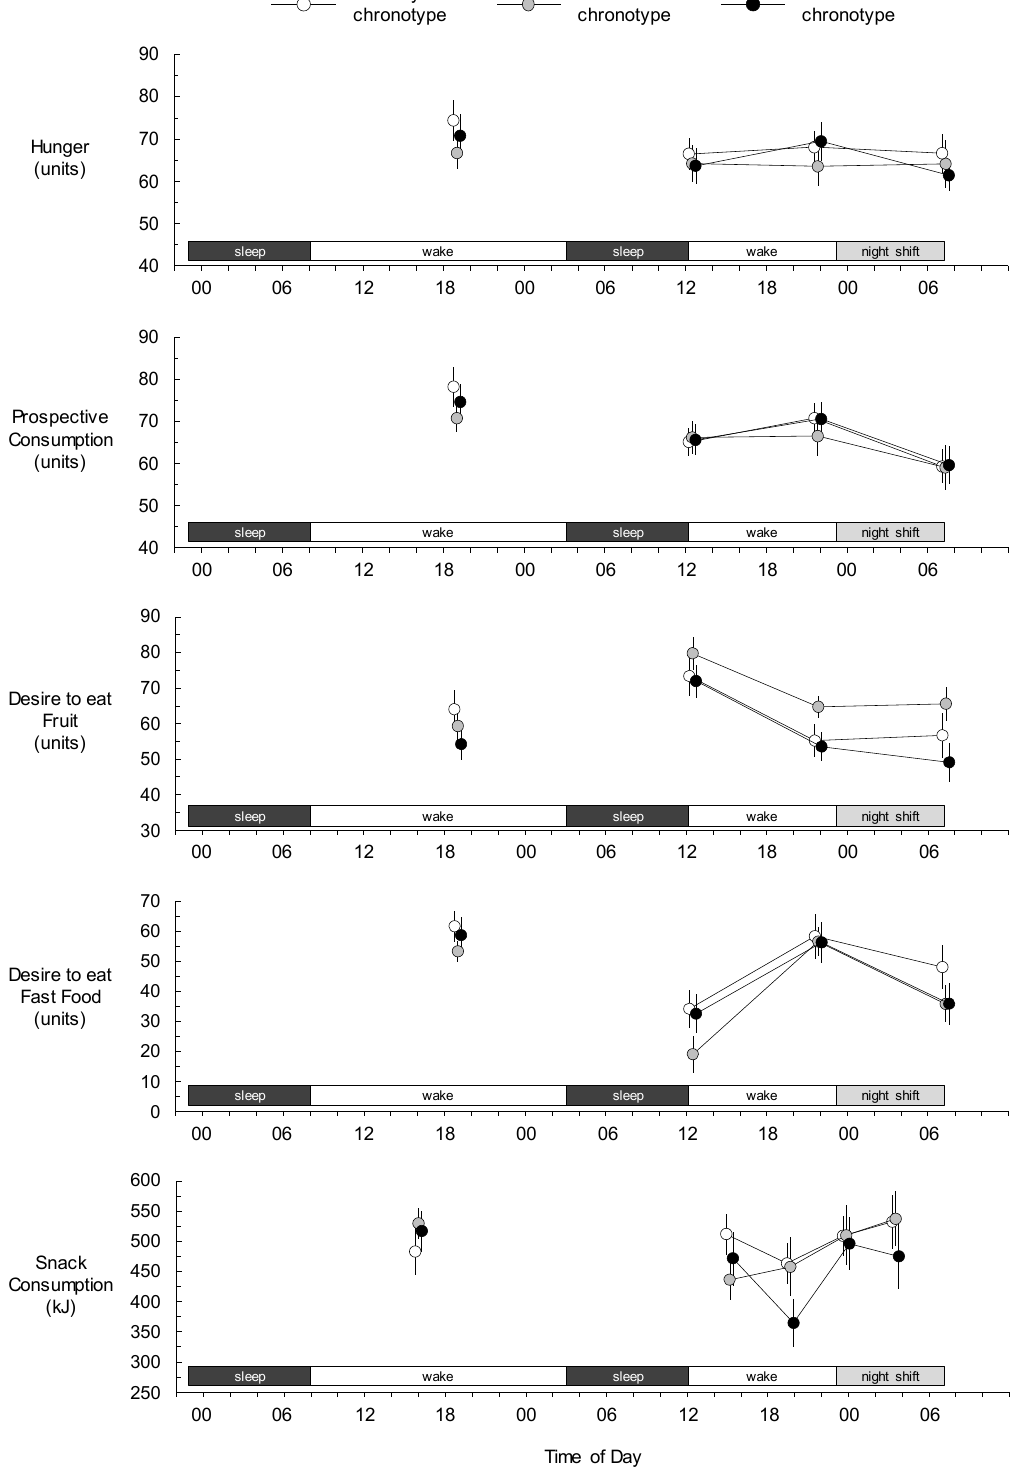
Figure 2. Hunger, prospective consumption, desire to eat fruit, desire to eat fast food, and snack consumption for early, intermediate, and late chronotypes. Baseline measures were collected during the first wake period. Mean values at each measurement have been offset to enhance interpretability. Error bars represent standard errors of the means.